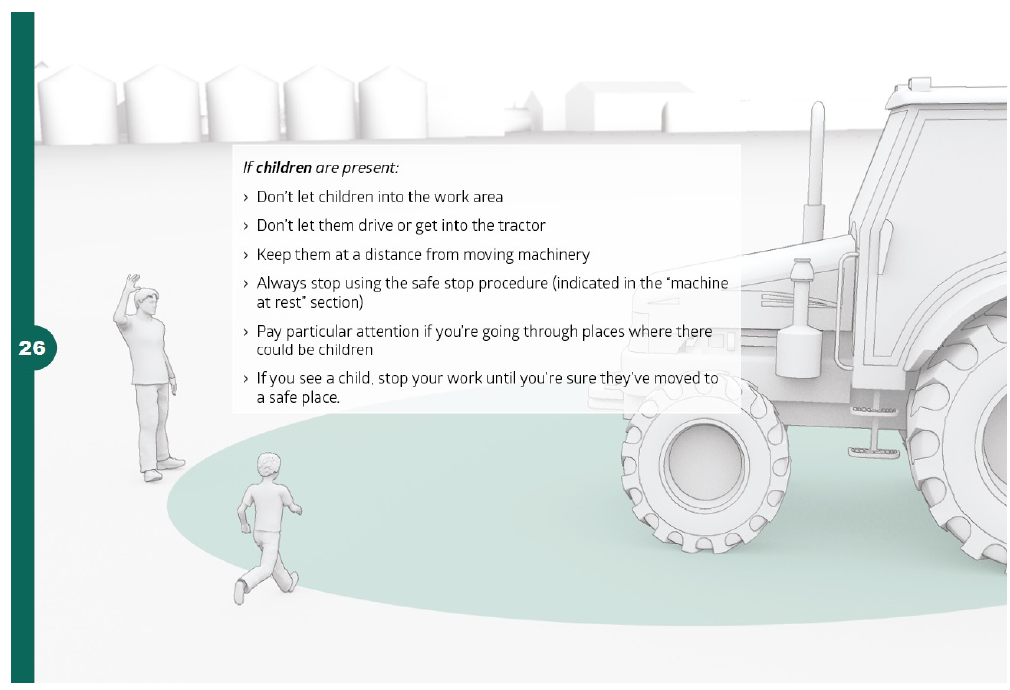
Figure 11. Example of a figure adopted to attract attention .